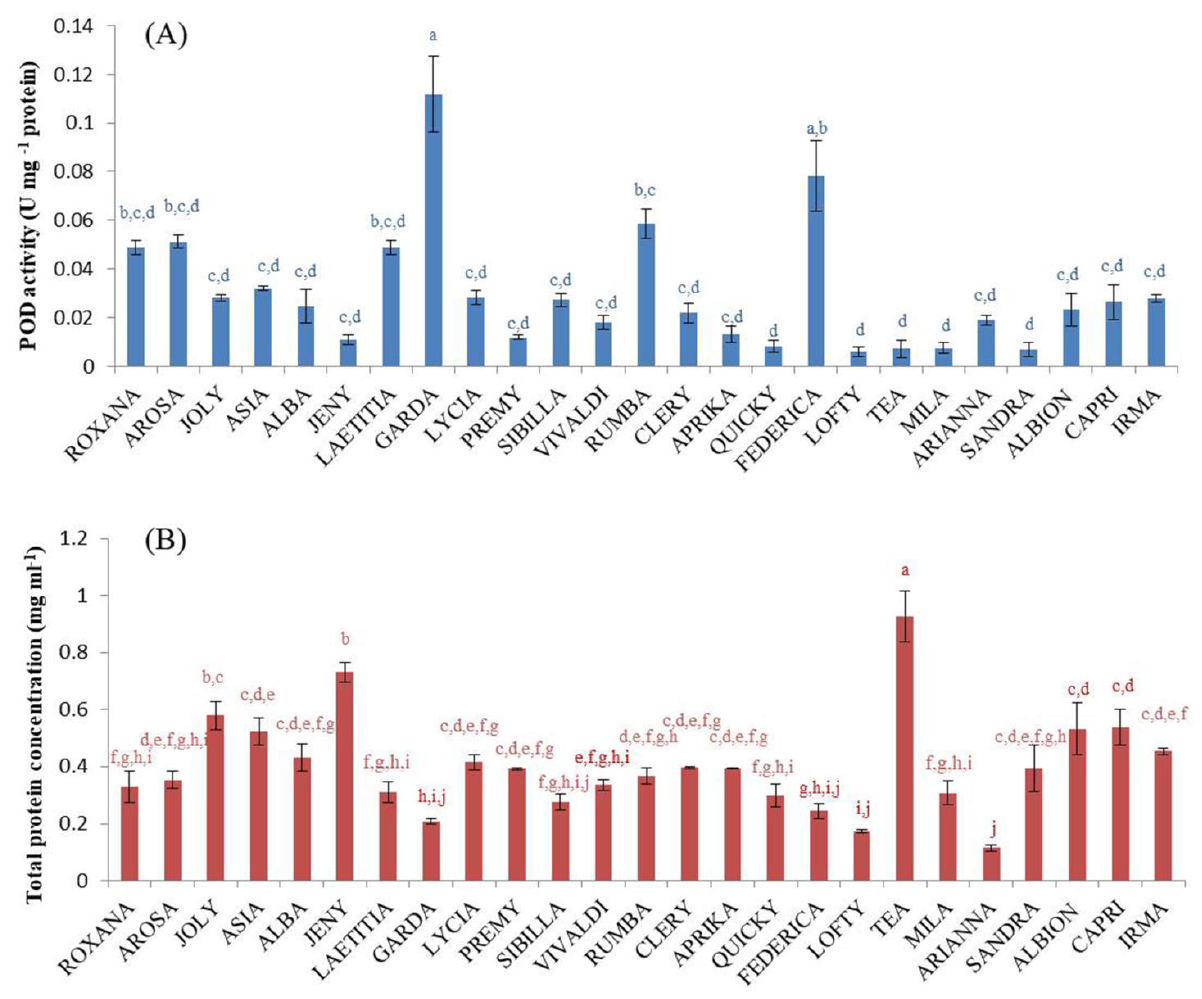
Figure 2. Specific activity of peroxidase (POD, U mg −1 prot, ( A )) and total protein concentration (mg ml −1 , ( B )) in strawberry fruit extracts. Data are presented as means (n = 3) ± standard error (SE). Bars with different lowercase letters are significantly different ( p < 0.05), as determined using the Duncan comparison test.